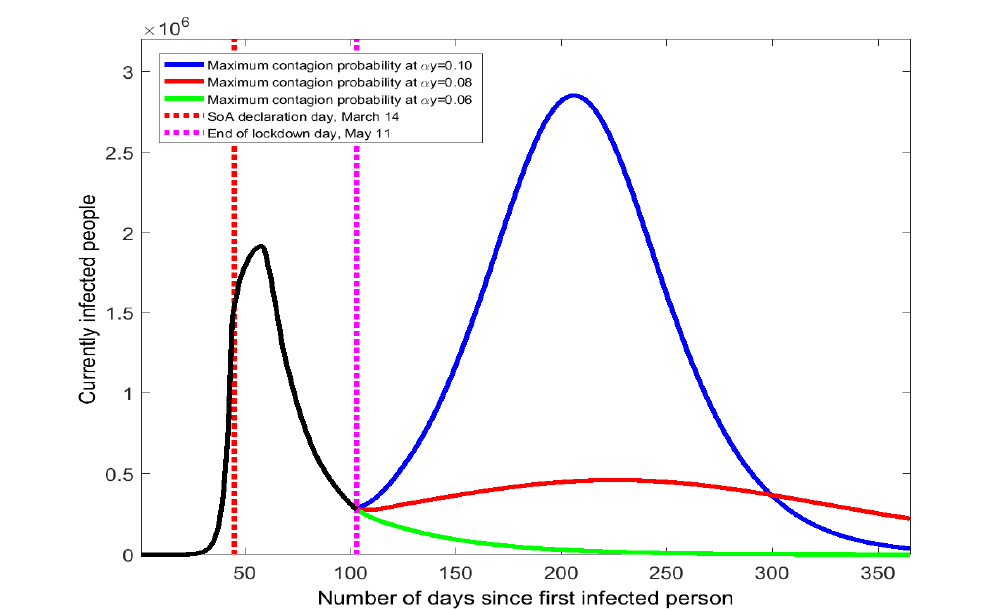
Figure 4. COVID-19 contagion spread Spain after the end of the state of